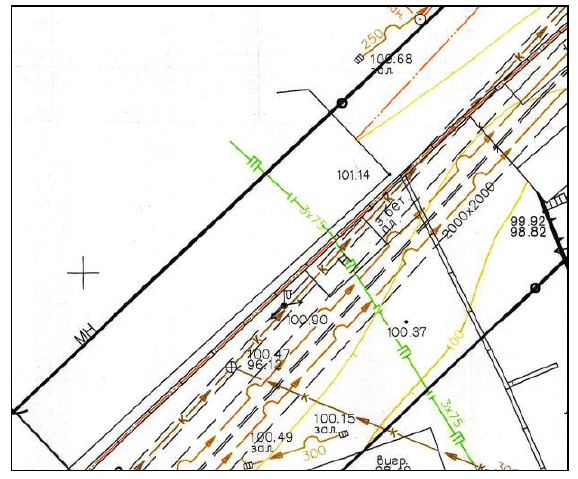
Figure 1b. A topographic plan fragment, scale 1: 500, drawn up in 2016, where the hydronym name is